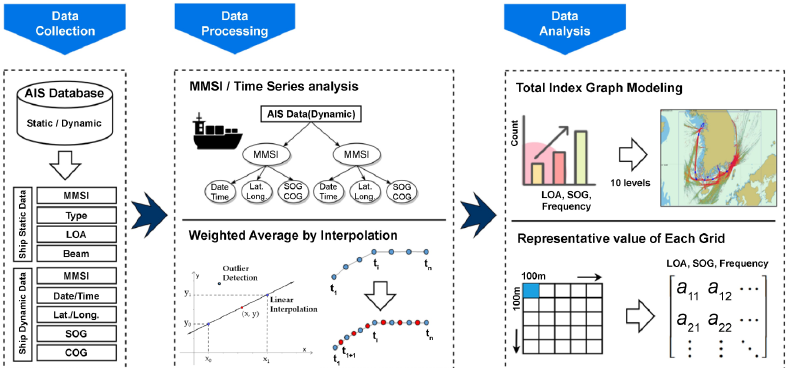
Figure 1. Conceptual diagram of the AIS data application plan.